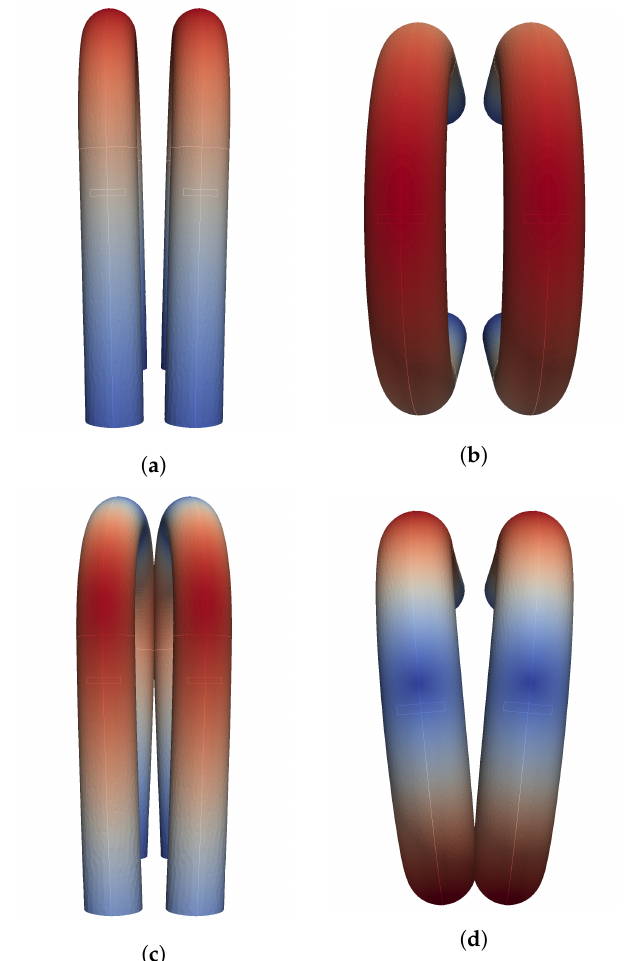
Figure 9. Geometry displacement due to excitation mode (mode 2) and Coriolis twist mode (mode 8). ( a ) Mode 2, front view; ( b ) Mode 2, top view; ( c ) Mode 8, front view; ( d ) Mode 8, top